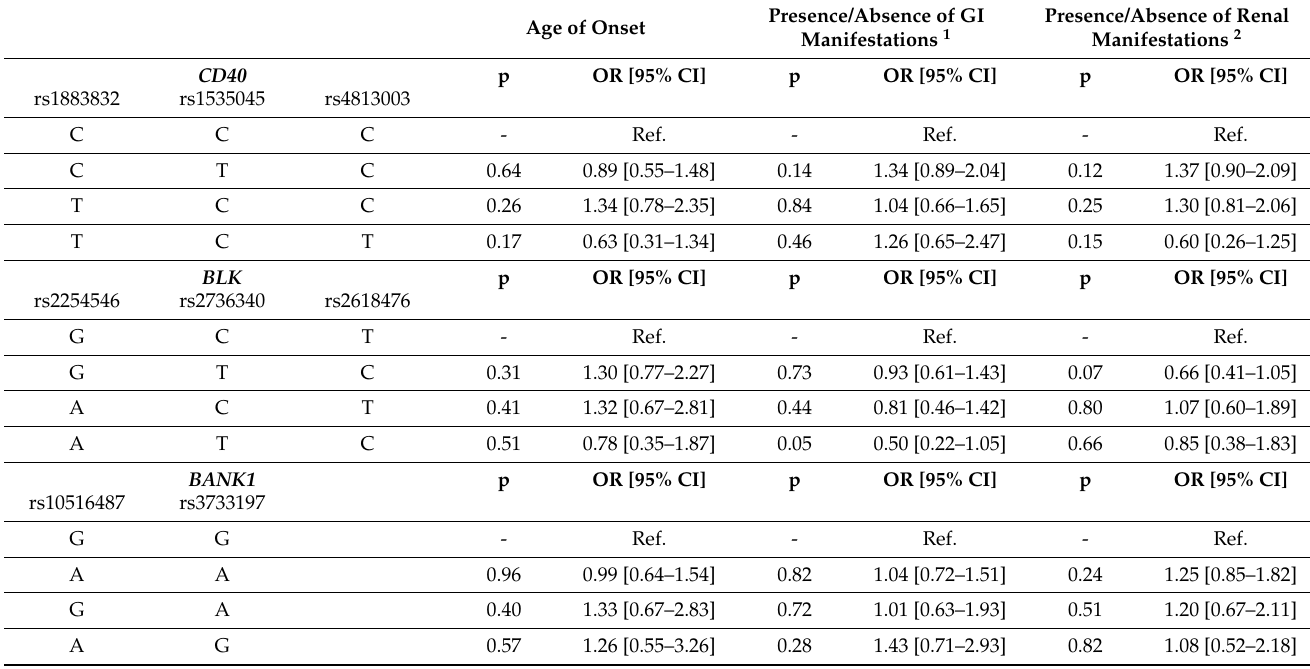
Table 5. CD40, BLK and BANK1 haplotype analysis in IgAV patients stratified according to clinical